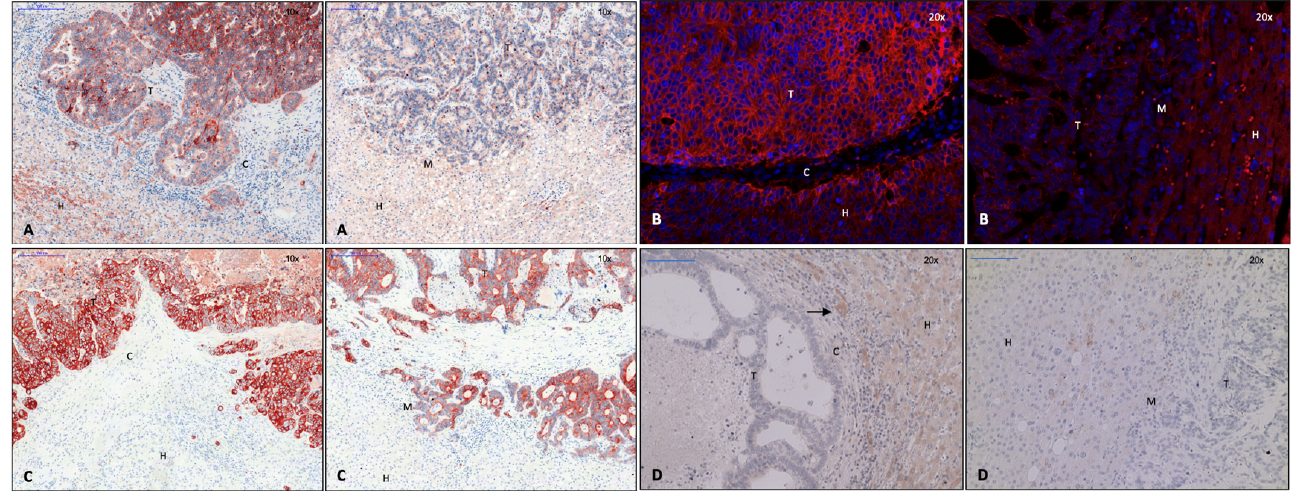
Figure 5. Left: capsule; right: no capsule. ( A ) E-cadherin immunohistochemistry, 10× magnification. Expression of E-cadherin is reduced at the tumor margin, especially in CRLM without capsule. ( B ) E-cadherin immunofluorescence, 20× magnification. Expression of E-cadherin is reduced at the tumor margin in CRLM without capsule. ( C ) Keratin-19 immunohistochemistry, 10× magnification. Intercellular expression of keratin-19 in the tumor area. In CRLM without capsule, expression is reduced at the tumor margin. ( D ) MAP1b immunohistochemistry, 20× magnification. Expression of MAP1b in cytoplasm of single liver cells surrounding the capsule (arrows). In CRLM, there was no evidence of MAP1b. Legend: T, tumor; H, hepatocytes; M, tumor margin; C, capsule.